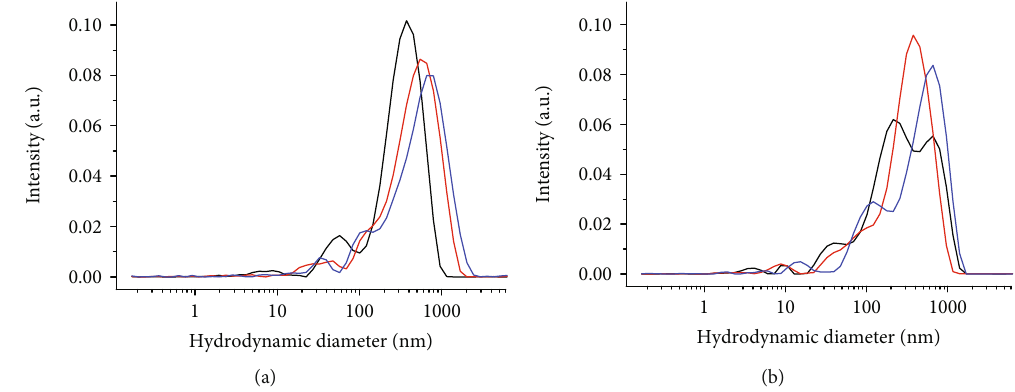
Figure 3: The dependence of the normalized scattering intensity on the hydrodynamic diameter of the scattering objects for the Polymer/AuNPs/Ce6 (black), Polymer/AuNPs/Dox (red), and Polymer/AuNPs/Ce6/Dox (blue) nanosystems at 25 ° C (a) and 37 ° C (b). Table 1: Composition of nanocomposites used for in vitro tests on MCF-7/S breast cancer cells.